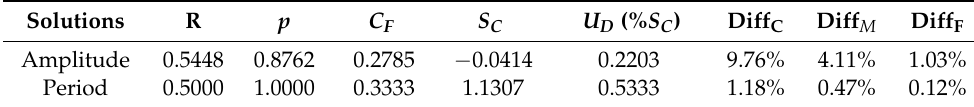
Table 6. Time-step uncertainties of free heave motion.